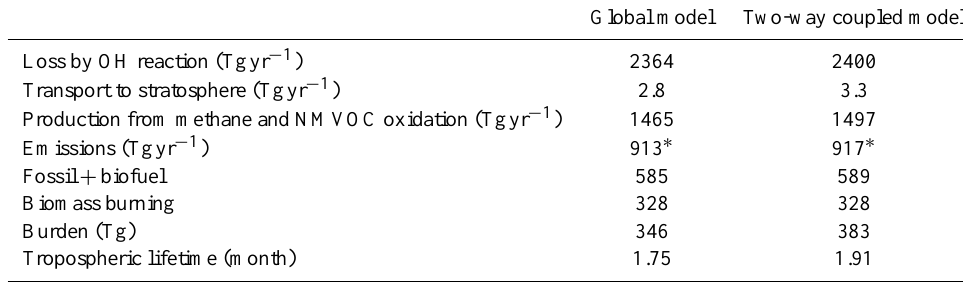
Table 2. Global budget of tropospheric CO for 2009.